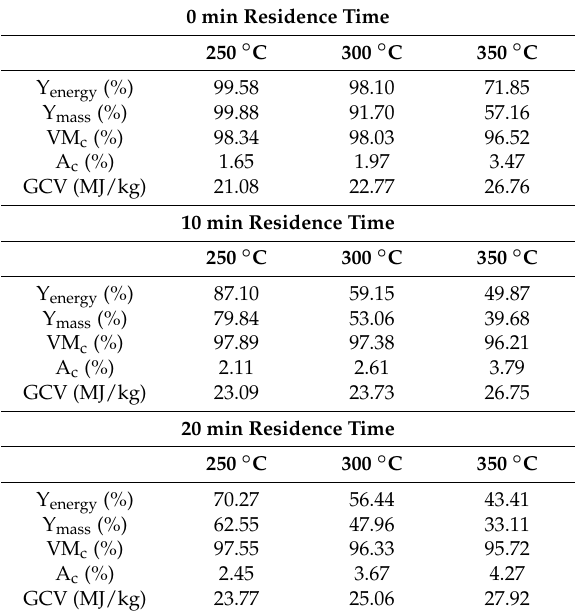
Table 2. Effect of torrefaction residence time on Energy Yield (Y energy (%)), Mass Yield (Y mass